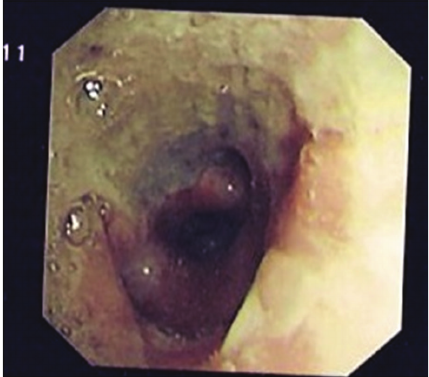
Figure 2: Bronchoscopy showing inflamed right bronchi and the subdivisions lined by a thick layer of yellow